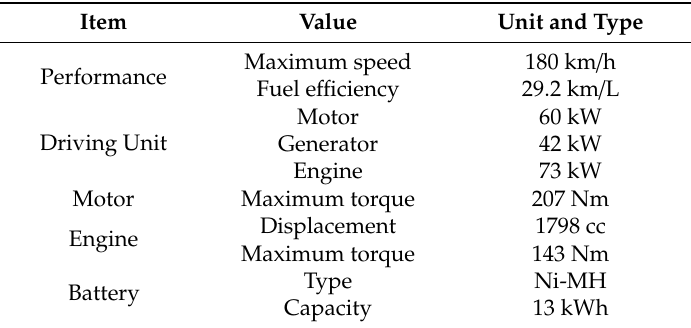
Table 1. Specifications of the test vehicle.